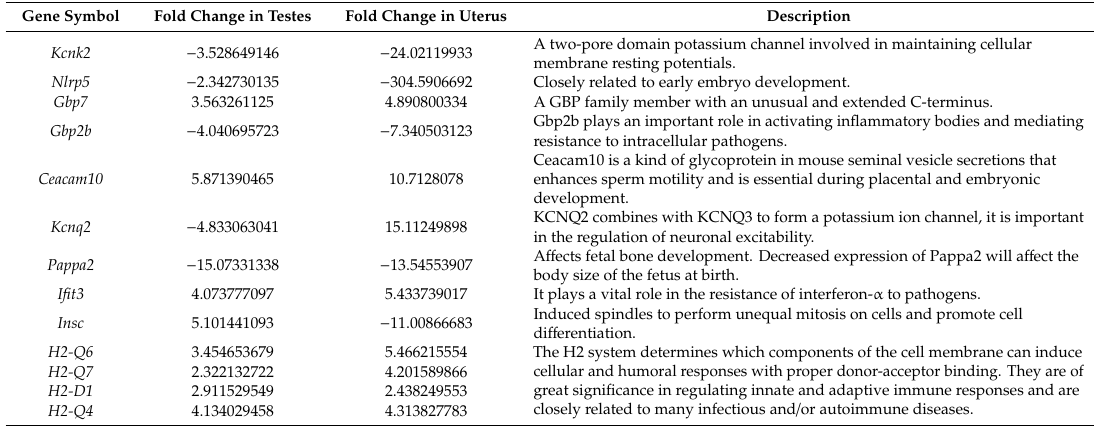
Table 4. Genes in the testes and uterus of infected mice.